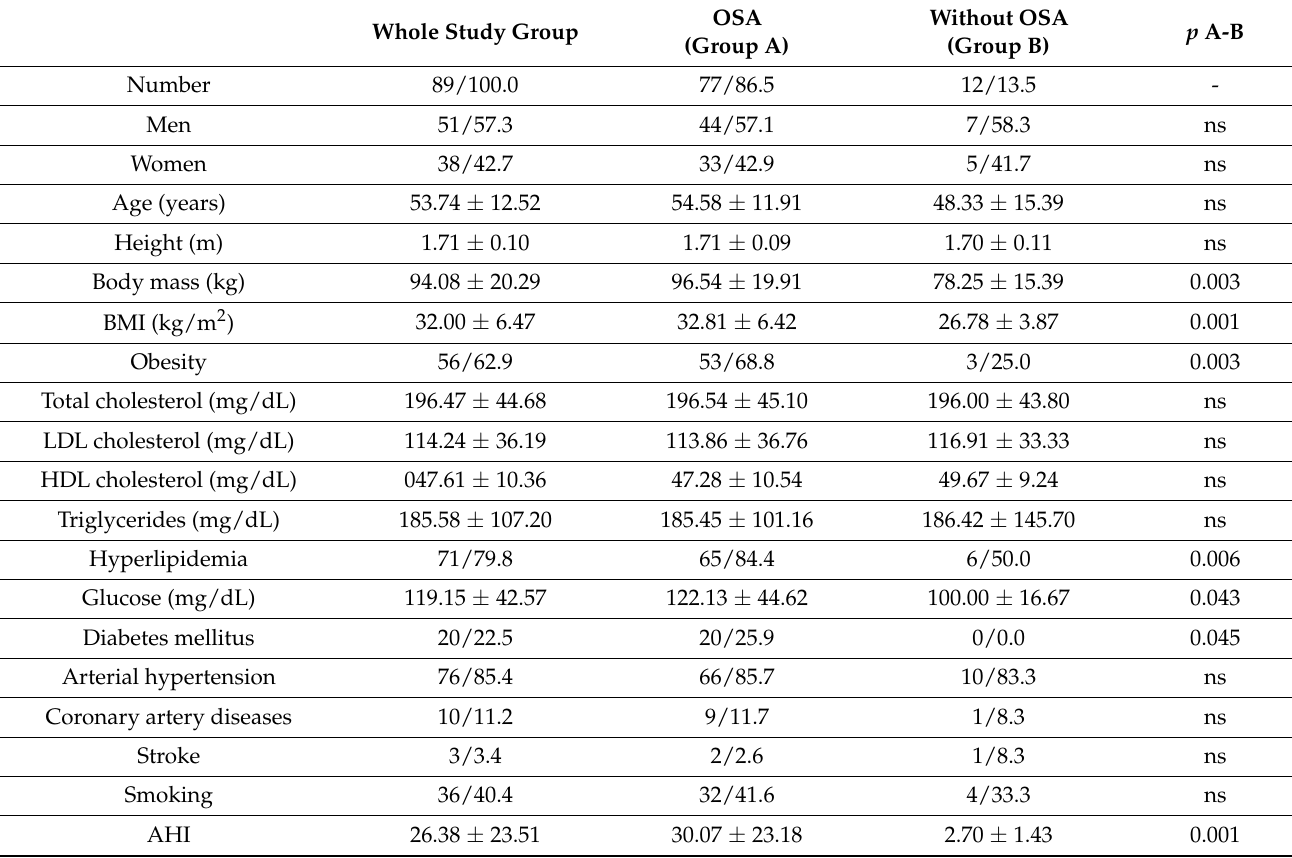
Table 1. Clinical characteristics of the study